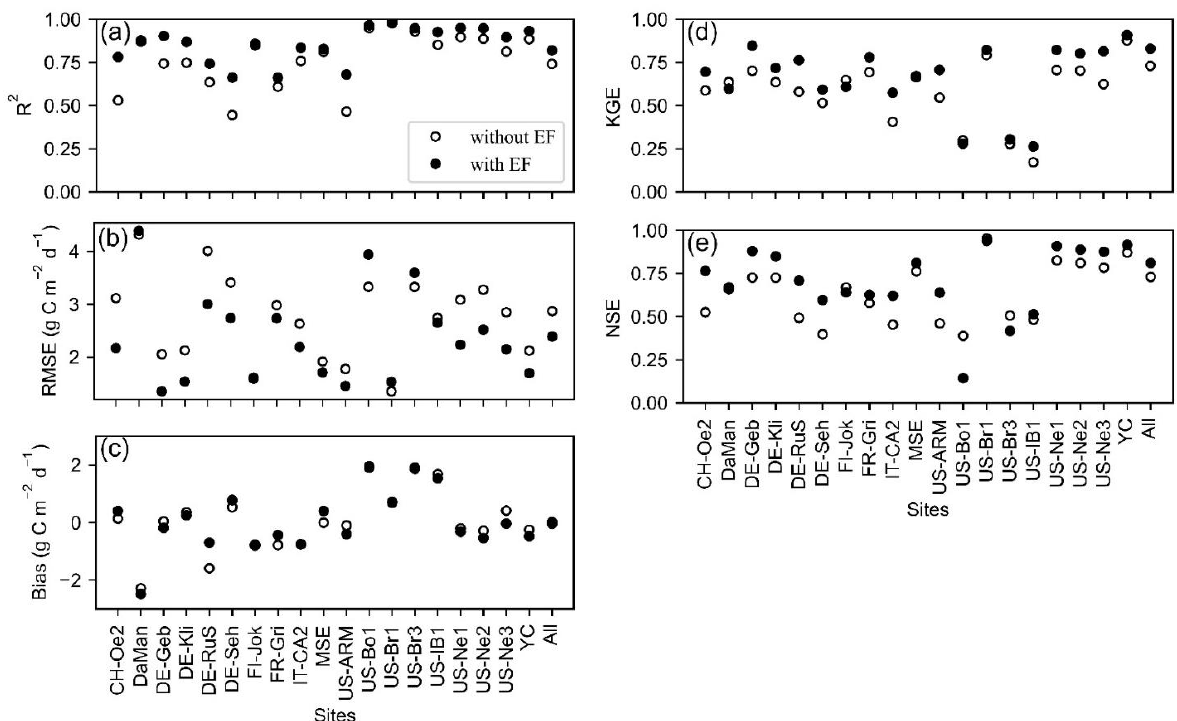
Figure 4. Comparisons between GPP estimated by the LUE models (with and without EF) and GPP measured by eddy covariance at flux tower sites (using validation sub-dataset): ( a ) R 2 ; ( b ) RMSE; ( c ) Bias; ( d ) KGE; ( e ) NSE. Solid and open circles represent the results from the EF-LUE model (i.e., with EF) and the LUE model without EF, respectively, driven by meteorological data from flux tower sites.